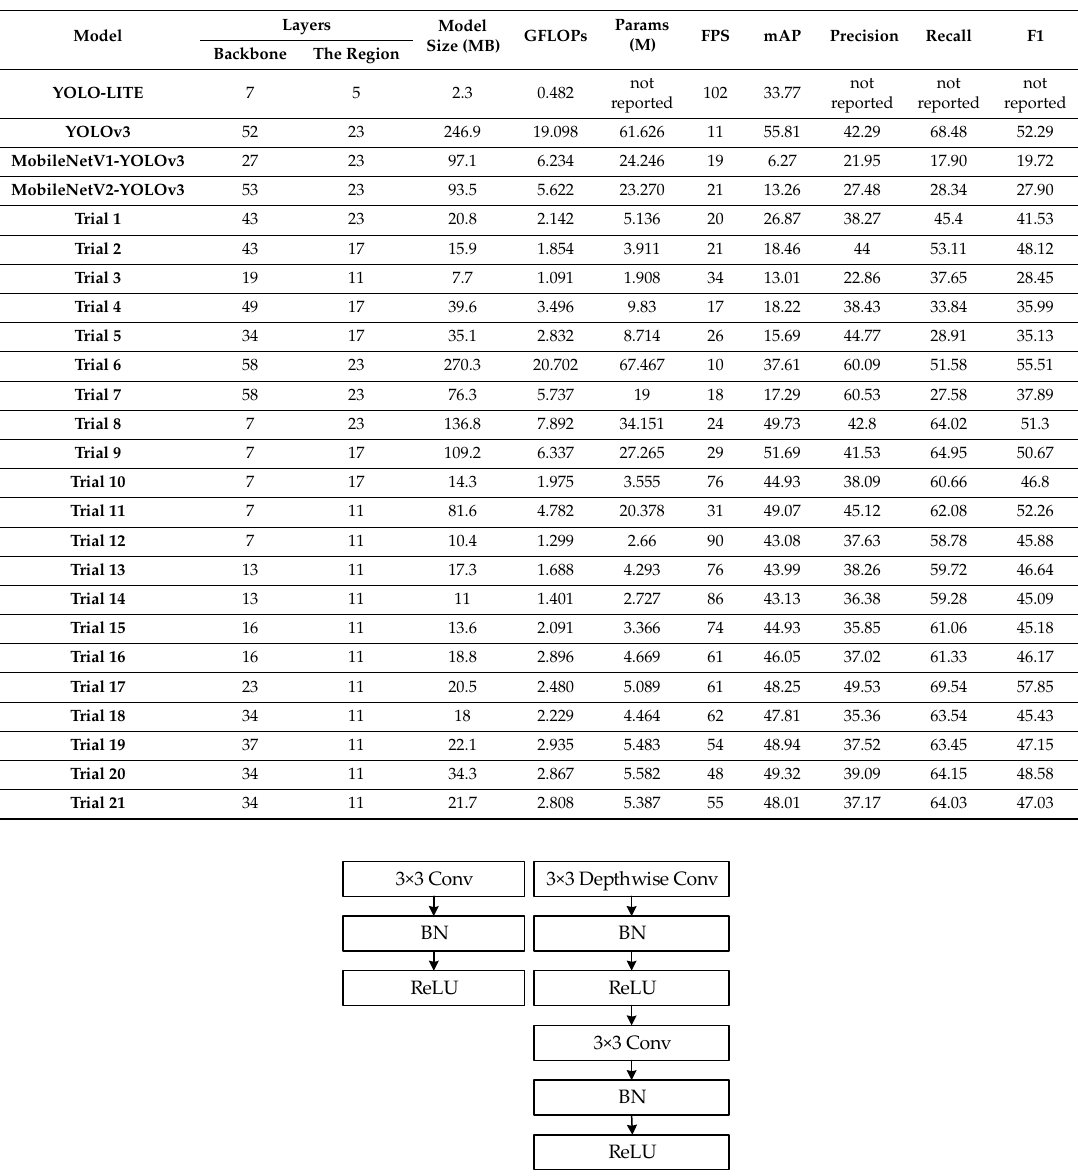
Figure 5. (Left ): standard convolutional layer with batchnorm (BN) and rectified linear unit (ReLU). ( Right ): depthwise-separable convolutions with depthwise and pointwise layers, followed by batchnorm and ReLU.